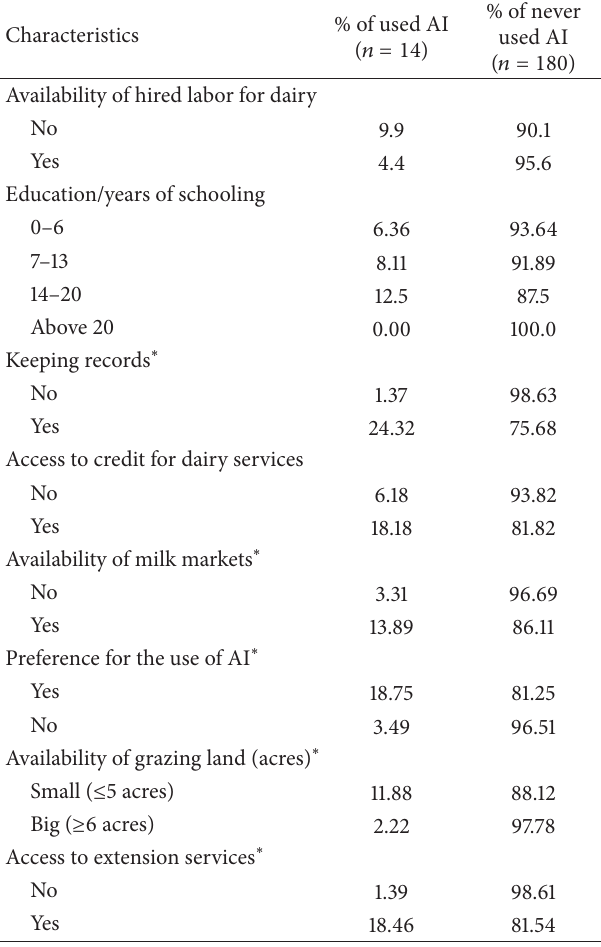
Table 3: Relationship between use of AI and socioeconomic factors of the farmers.